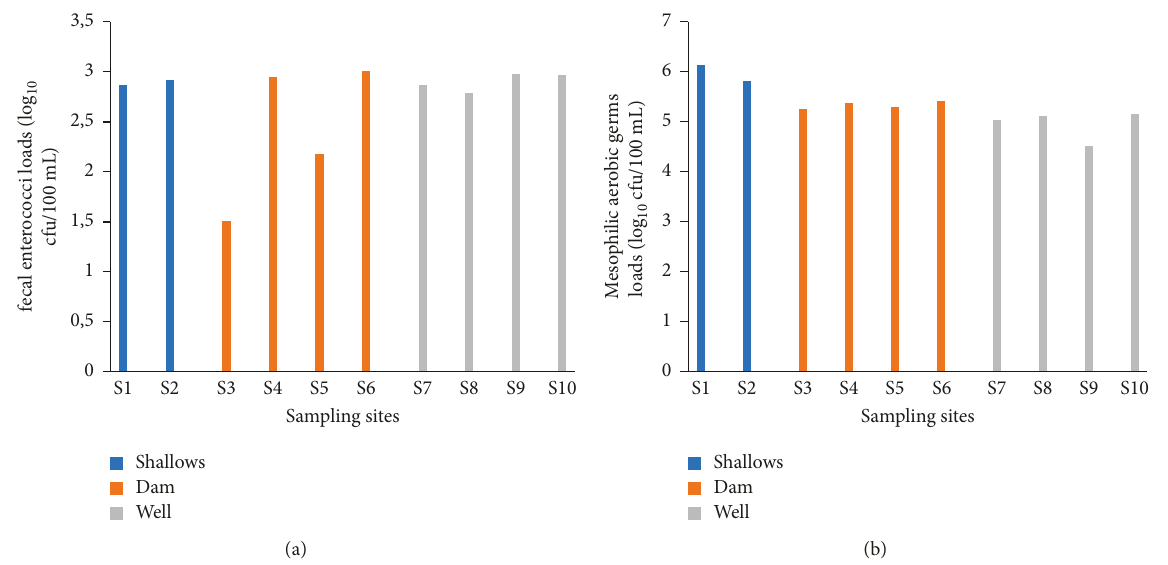
Figure 3: Fecal enterococci (a) and mesophilic aerobic germs (b) counts in irrigation water.